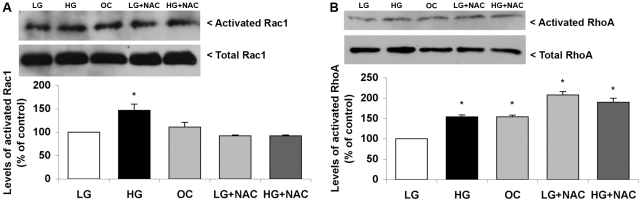
High glucose leads to Rac1 and RhoA activation in CHO.K1 cells.Representative western blotting showing the results of a pull-down assay for Rac1 activation and total Rac1 (A), as well as for RhoA activation and total RhoA (B) in control (LG), high glucose (HG) and osmotic control (OC), in the presence or absence of 10 mM N-acetylcysteine (NAC) for 1 hour. The ratio between activated and total proteins was measured by densitometry. Protein bands shown are representative of the experiments, and the results from 4 independent experiments were expressed as percentage of the control (LG) ± SEM. (*) P≤0.05 according to one-way analysis of variance (ANOVA) followed by Tukey's post-test.